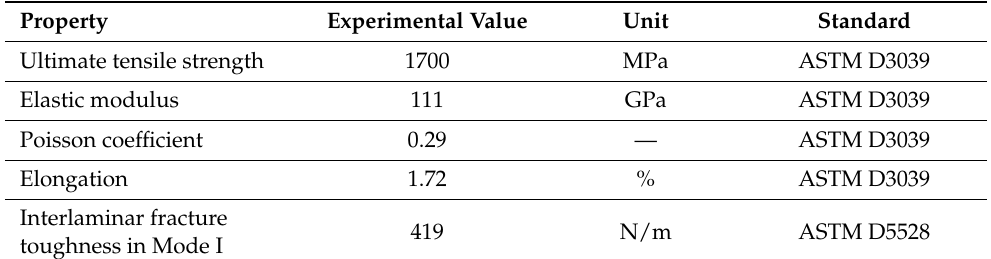
Table 1. Mechanical properties of prepreg CIT HS160 T700 ER450 UD tape 36% [41]. Property Experimental Value